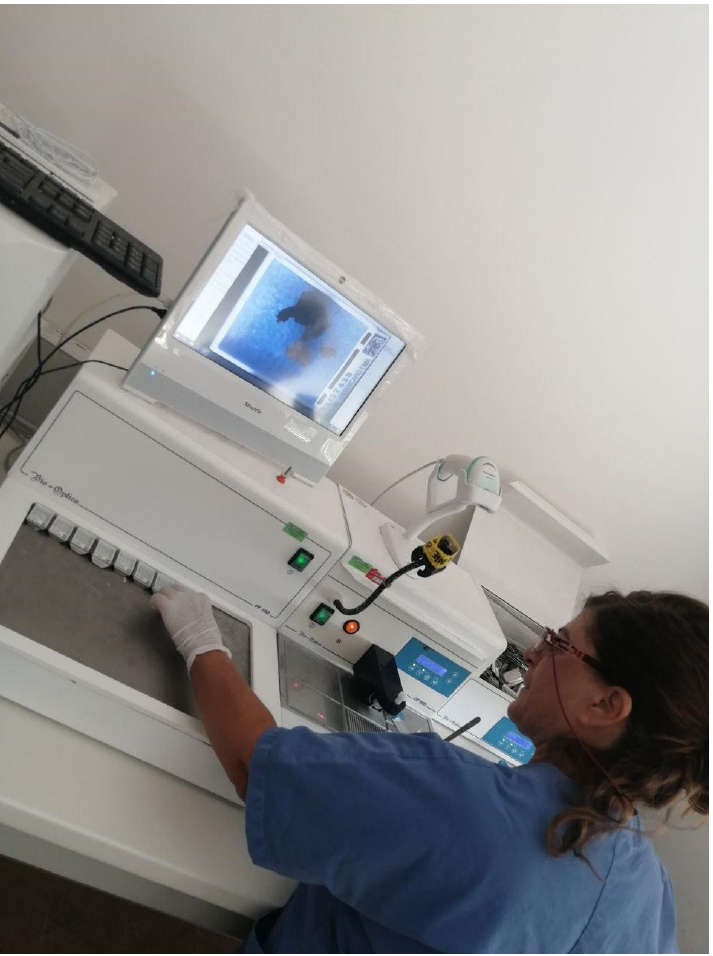
Figure 6. The BlocDoc at the embedding phase